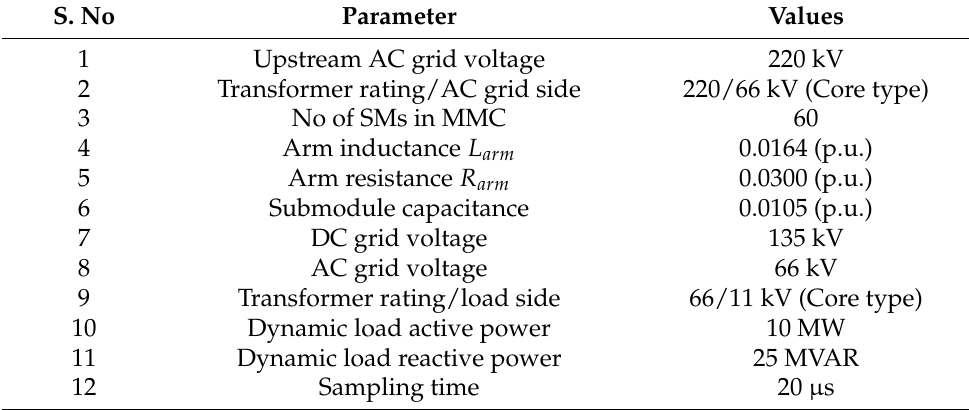
Table 4. Parameters of upstream AC, DC grid and modular multilevel